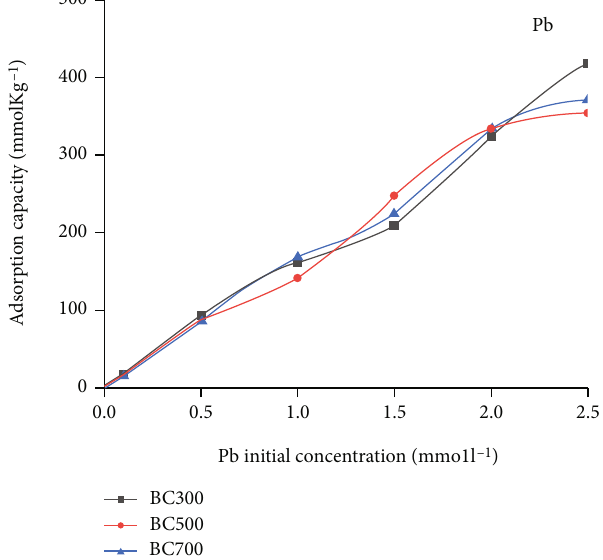
Figure 6: Adsorption rate of paddy carbon on Cd 2+ in di ff erent concentrations of heavy metal ions in mixed working fl